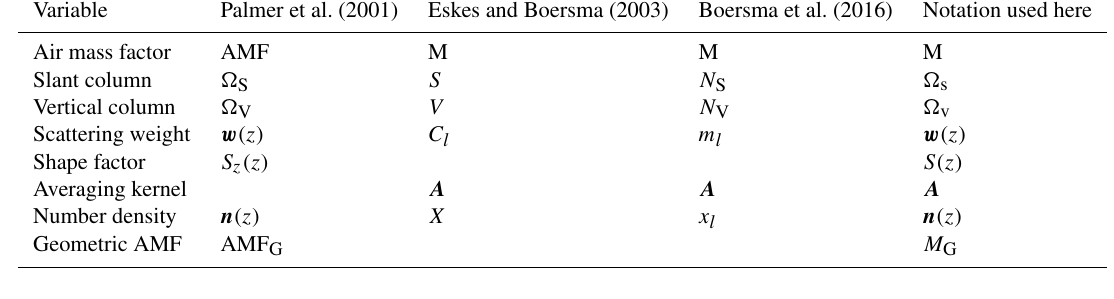
Table 1. Lexicon comparing notation used in this paper to that used in previous studies.